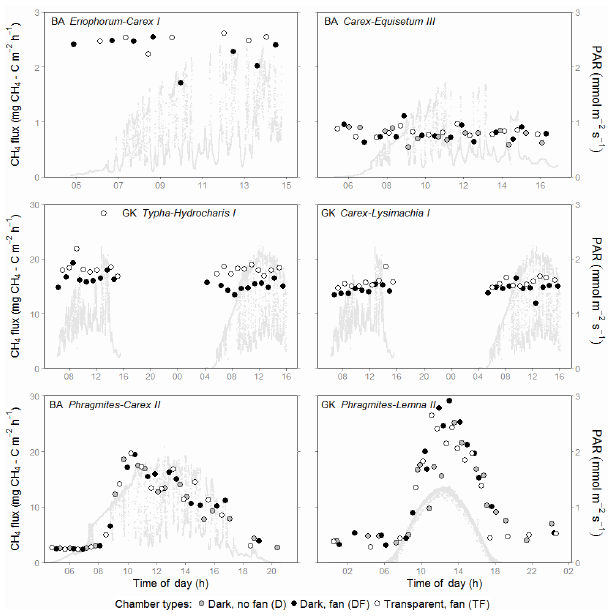
Figure 3. Diurnal variation of methane emissions, measured with different chamber types, and outside PAR, at BA Eriophorum– Carex (plot I, 18 July 2012), BA Carex–Equisetum (plot III, 16 September 2012), BA Phragmites–Carex (plot II, 8 Au- gust 2012), GK Typha–Hydrocharis and GK Carex–Lysimachia (both plot I, 12 July 2012 and 13 July 2012), and GK Phragmites– Lemna (plot II, 21 September 2011). Data of BA Phragmites–Carex and GK Phragmites–Lemna are from Minke et al.